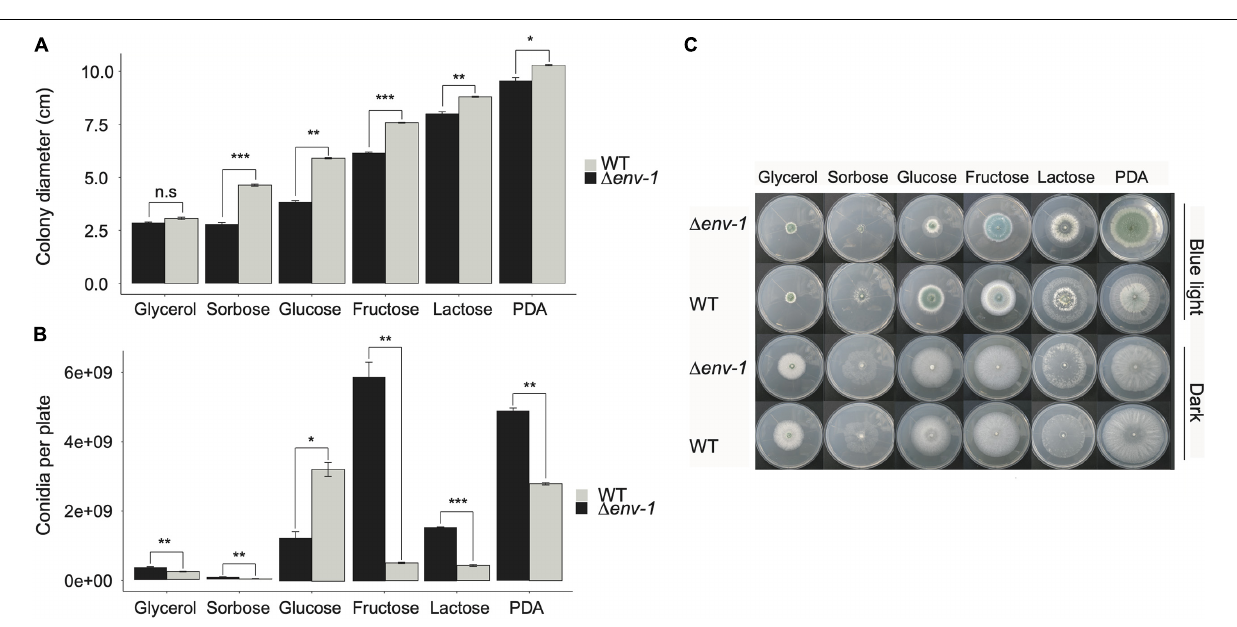
FIGURE 4 | Development and growth of the WT and (cid:49) env -1 mutant on different carbon sources. (A) Variation in the growth of the WT strain and the (cid:49) env -1 mutant in media with different carbon sources. (B) Variation in the conidiation of the WT strain and the (cid:49) env -1 mutant in media with different carbon sources. (C) Growth phenotype of the WT strain and the (cid:49) env -1 mutant grown on different carbon sources and under constant light and darkness. A t -test was used to determine the significant differences between each pair of strains for each carbon source, indicated by asterisks according to the significance ( P > 0.05; no significant difference; n.s., * P < 0.05, ** P < 0.01, *** P < 0.001; n =